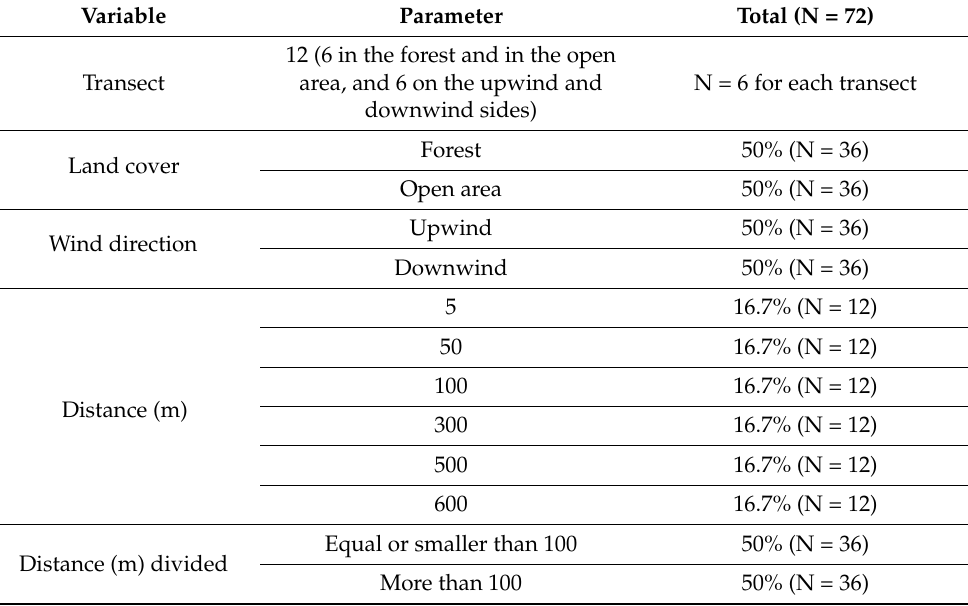
Table 1. Characteristics of calculation parameters.